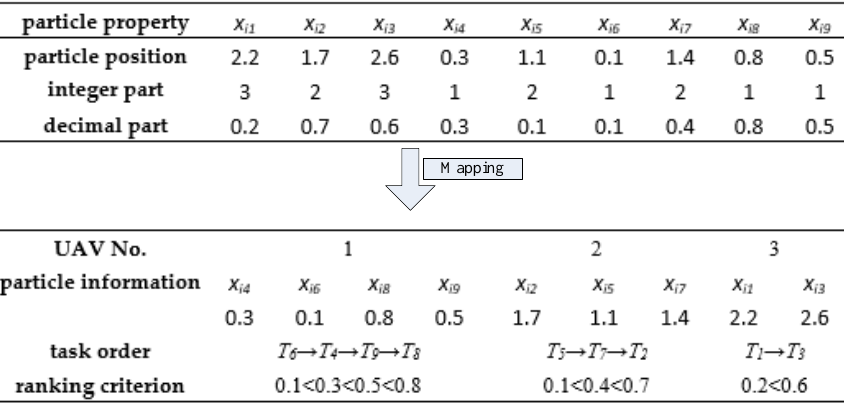
Figure 1. Mapping relationship between particle coding and UAV task assignment